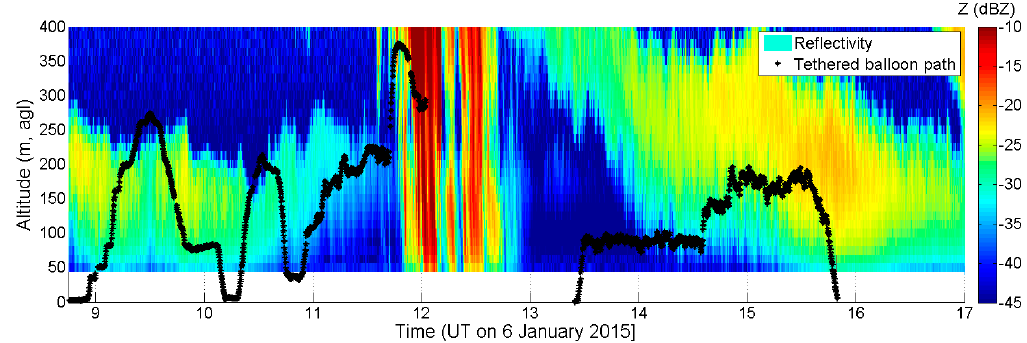
Figure 11. Time series of cloud radar reflectivity on 6 January 2015 and tethered balloon flight trajectory in cloud layer (black markers).